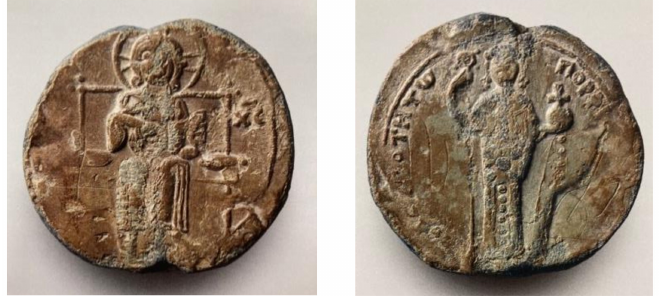
Figure 11. Seal of John; Zacos Collection, Geneva; Inv. CdN 2004-582. Published in